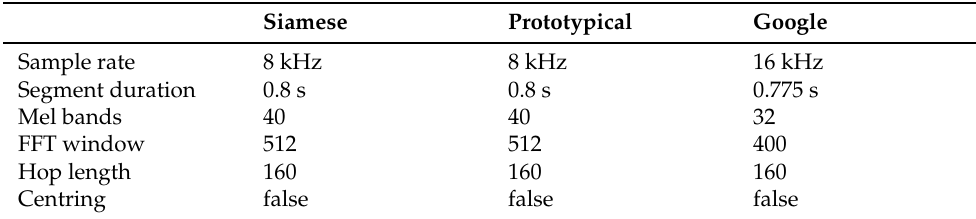
Table 1. Parameters of mel spectrogram preprocessing for each model type.